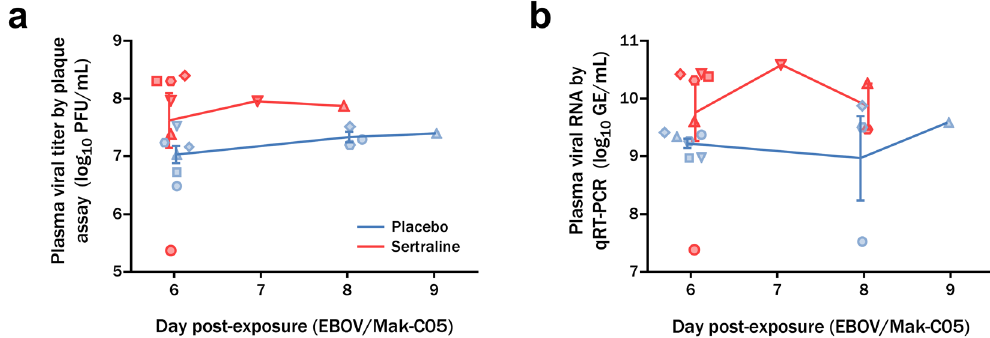
Figure 4. Circulating viremia of sertraline and placebo treated animals exposed to a lethal dose of Ebola virus. Animals were treated with 200 mg sertraline hydrochloride (red) or placebo (blue) by orogastric tube. Log 10 plasma viremia levels as measured by plaque assay ( a ) and qRT-PCR ( b ) are shown as group means with SEM. Individual values are depicted as shapes. By day 6 post-exposure, animals exhibited substantial viremia that persisted until death. Statistical analysis showed no significant difference between placebo and sertraline treatment at